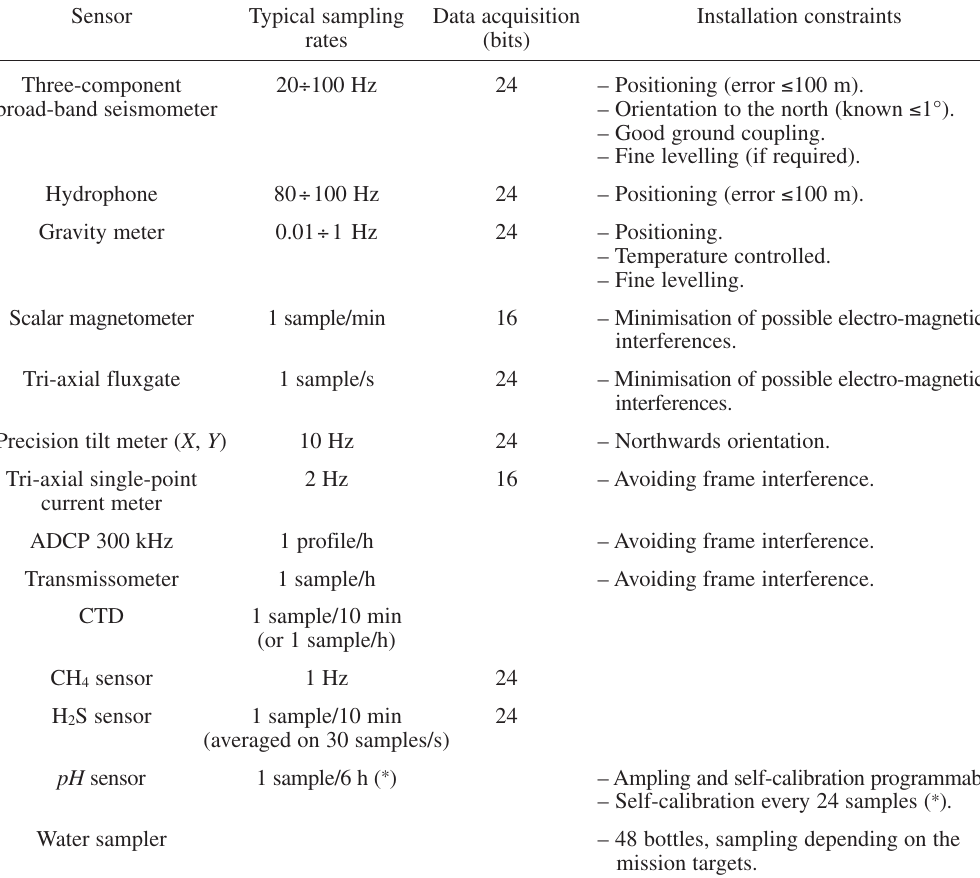
Table I. Requirements for the instrumentation used in seafloor observatories.